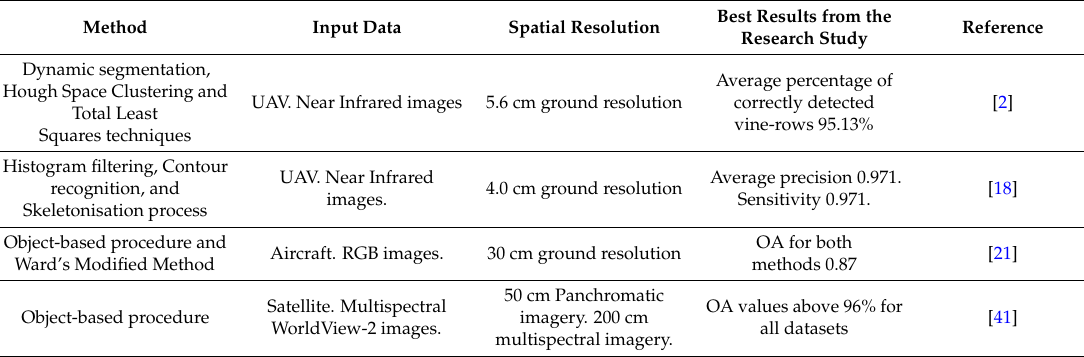
Table 5. Comparison of recent studies related to canopy vineyard